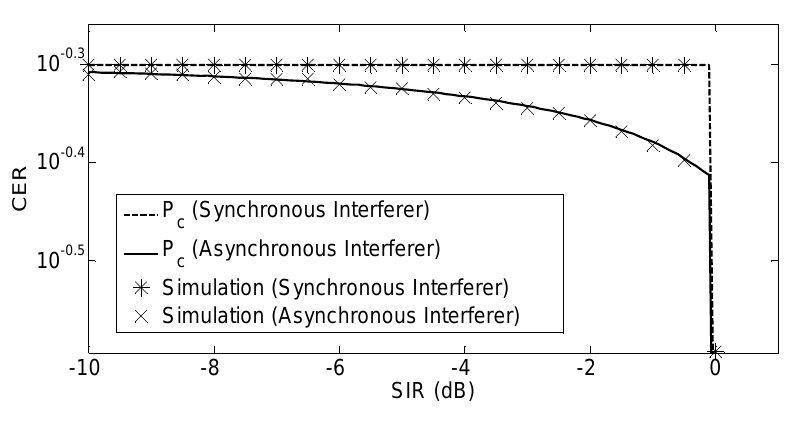
Figure 6. Non-coherent chip error